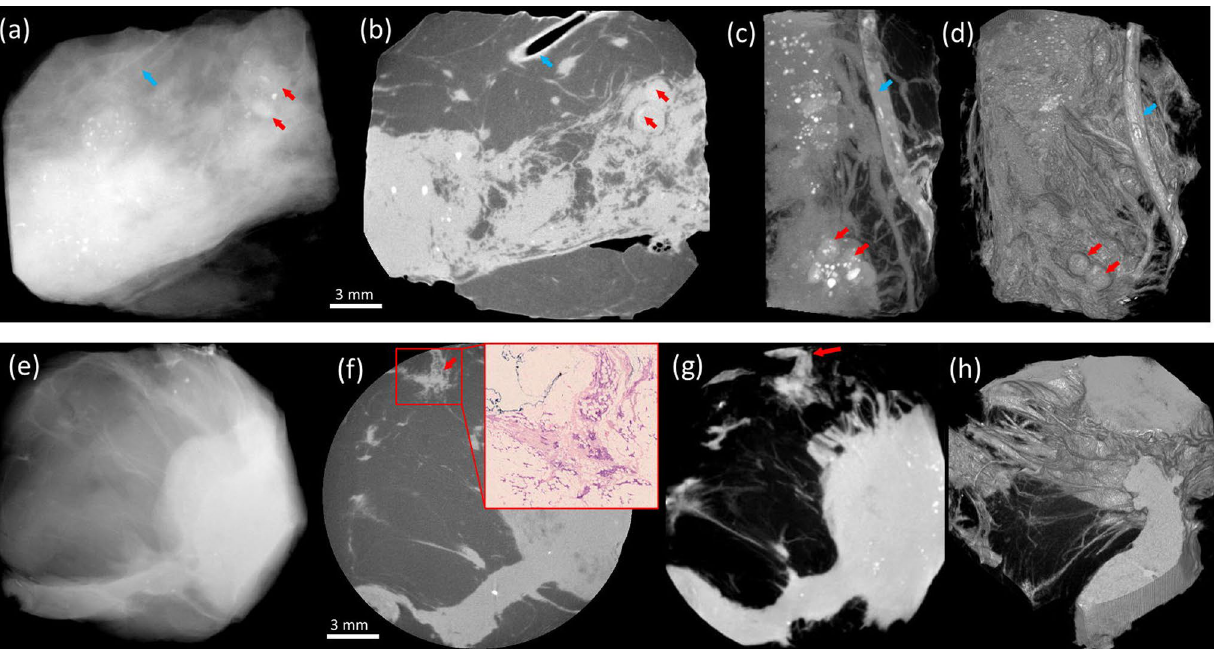
Figure 2. Versatility of representation offered by the XPCI-CT approach. The top row focuses on calcified DCIS, also detectable in the conventional image ( a ). However, the clear delineation of the enlarged ducts in the XPCI slice ( b ) should be noted (red arrows), which can be followed along their length through successive slices. Alternatively, MIPs can be used ( c ), or more sophisticated 3D rendering approaches such as solid casting followed by segmentation (e.g. fat tissue was segmented out in panel d, allowing the visualisation of an entire blood vessel and calcifications therein, blue arrow). The bottom row shows an involved margin, less clearly visible in the conventional image ( e ) and highlighted by an arrow in the XPCI slice ( f ), where the inset shows confirmation by histopathology, and in the MIP in ( g ). The 3D rendering in ( h ) allows visualising edge of the tumour (a metaplastic carcinoma), characterised by diffuse invasion along fibrous strands.